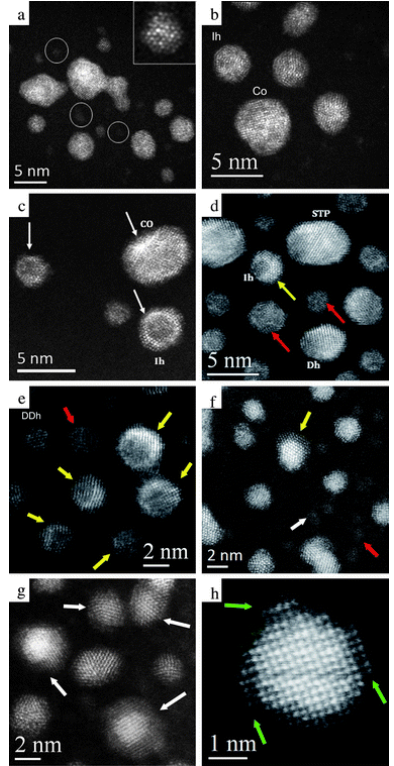
Figure 5. STEM HAADF images of the ( a , b ) (Au + Pd); ( c – e ) (Au@Pd) and ( f – h ) (Pd@Au). Republished with permission of Royal Society of Chemistry from ref. [54]; permission conveyed through Copyright Clearance Center, Inc.